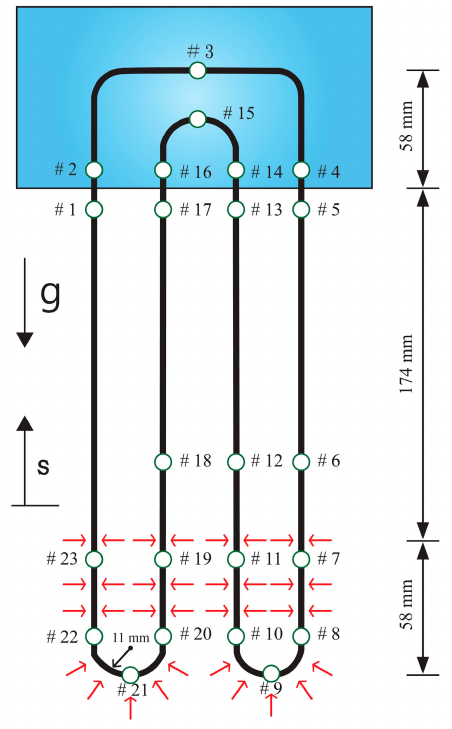
Figure 1. Schematic of the experimental